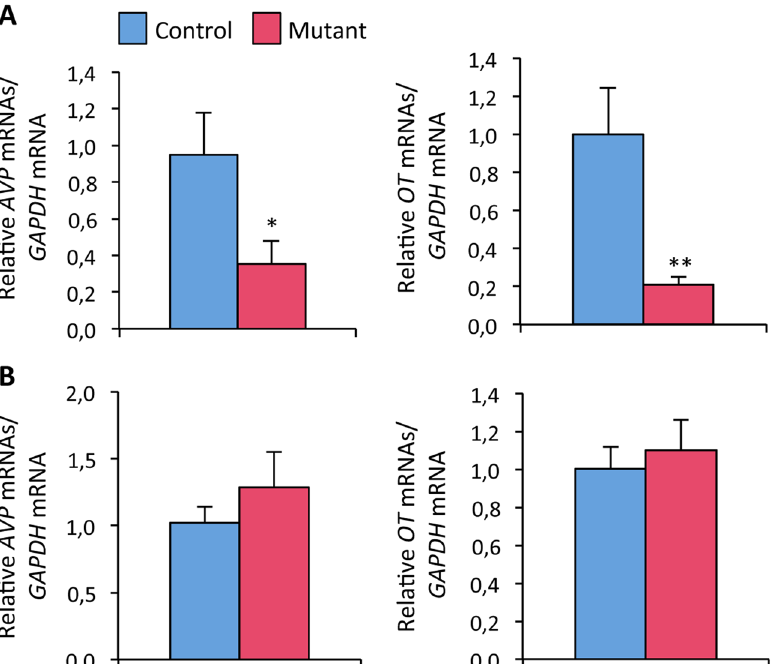
Figure 7. Effects of neural ER β deletion on OT and AVP expression in male mice. ( A ) Levels of AVP ( Left ) and OT mRNAs ( Right ) normalized to GAPDH expression in the bed nucleus of stria terminalis of males (n = 9 animals per genotype). * p < 0.05 or ** p < 0.01 versus controls. ( B ) Levels of AVP (Left) and OT (Right) expression normalized to GAPDH in the hypothalamic paraventricular